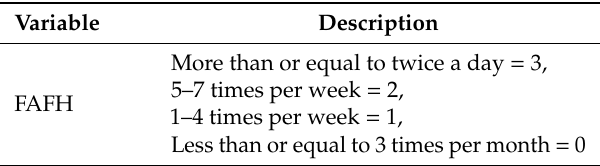
Table 1. Description of multivalued hypothetical treatment variable.